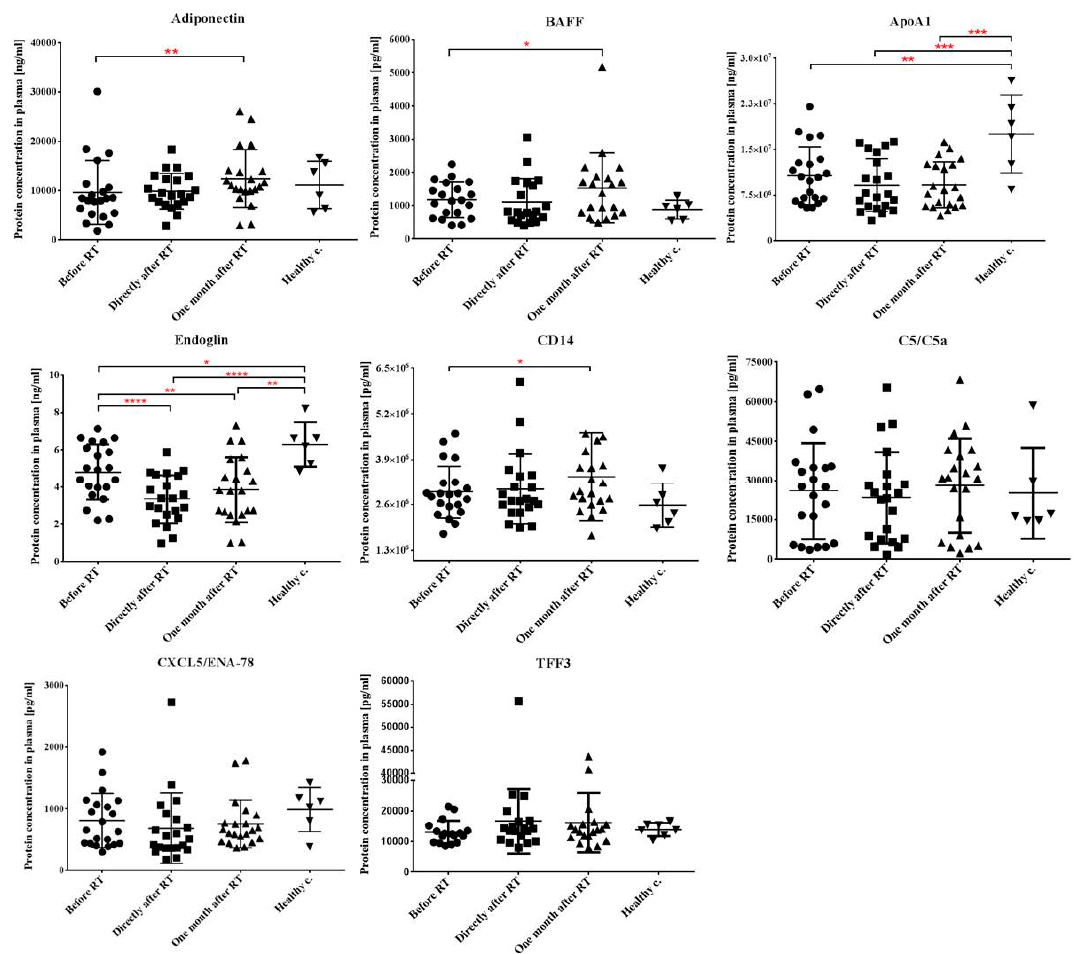
Figure 2. Levels of immune- and inflammation-related proteins in the plasma of HNSCC patients before and after radiotherapy. Blood was collected from cancer patients before the start of the treatment, directly after and one month after the last fraction of RT as well as from healthy volunteers. Plasma was isolated and concentration of the indicated proteins was measured by ELISA as described in Materials and methods. Absolute levels of protein concentration are indicated. Data are shown as individual data points ( n = 23 for patients, n = 6 for healthy controls) together with the mean ± SD. Significant differences were tested with paired- t -test with 95% confidence interval (* p < 0.05, ** p < 0.01, *** p < 0.001, **** p < 0.0001).